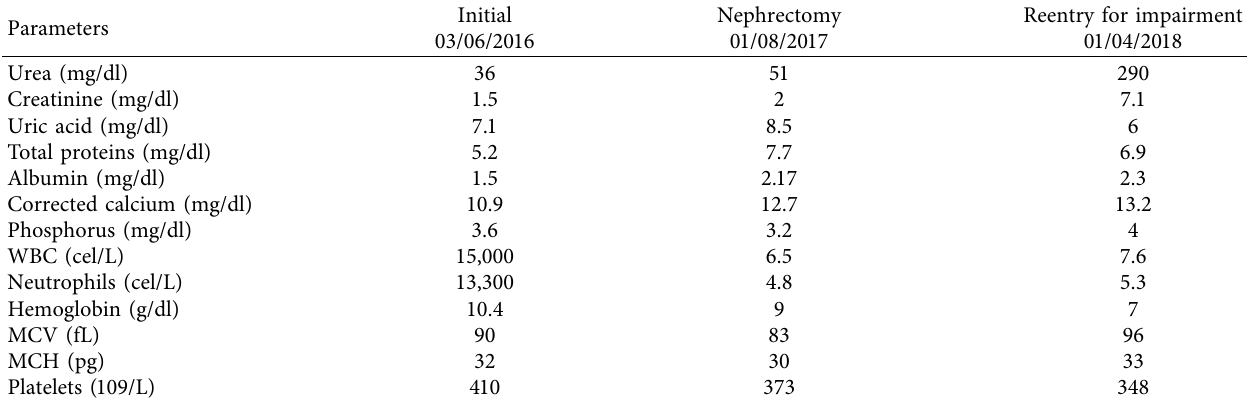
Table 1: Laboratory and clinical findings in a chronological